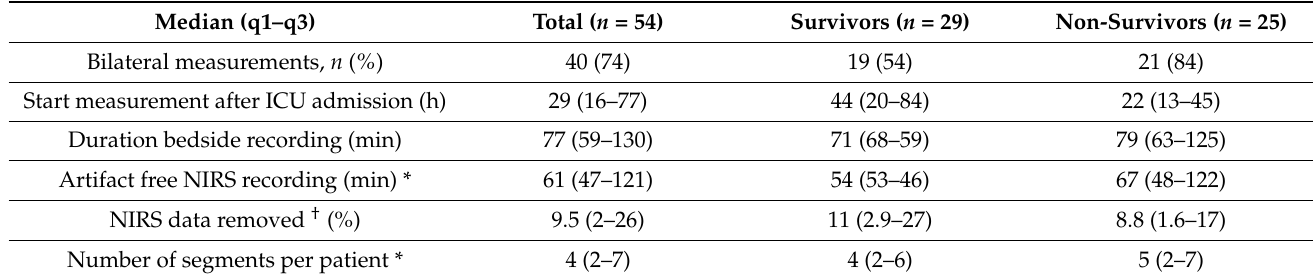
Table 3. Near infrared spectroscopy data length and quality dichotomized for six-month